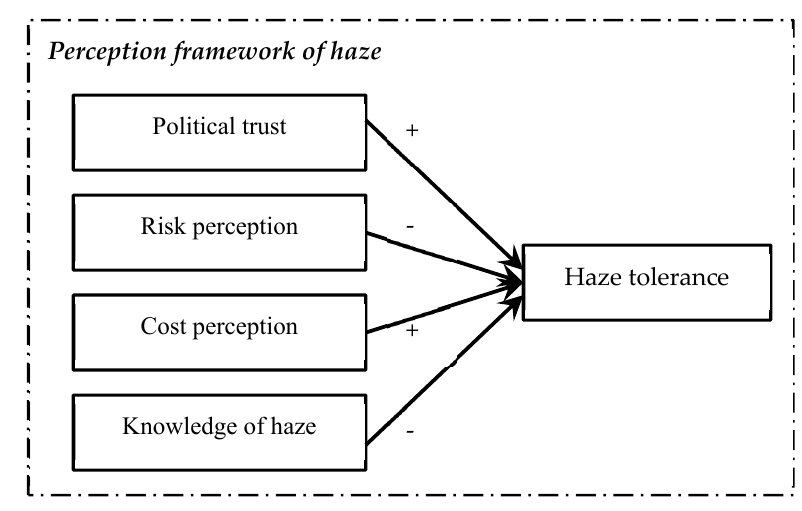
Figure 1. Theoretical framework of public perception towards haze.